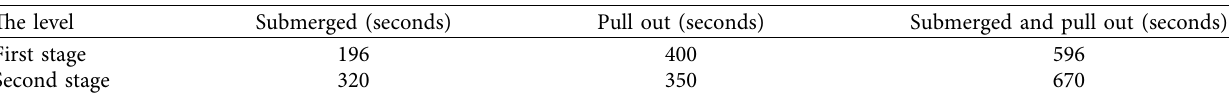
Table 3: The average time of sinking and pulling out the piling in the alternative materials in the first and second stage. The level